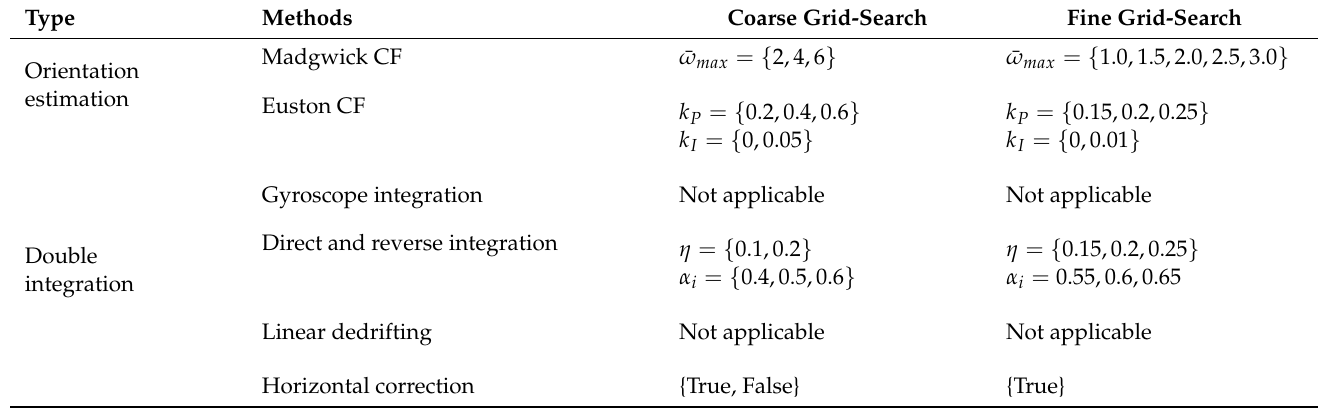
Table 2. Methods and parameters used in coarse and fine